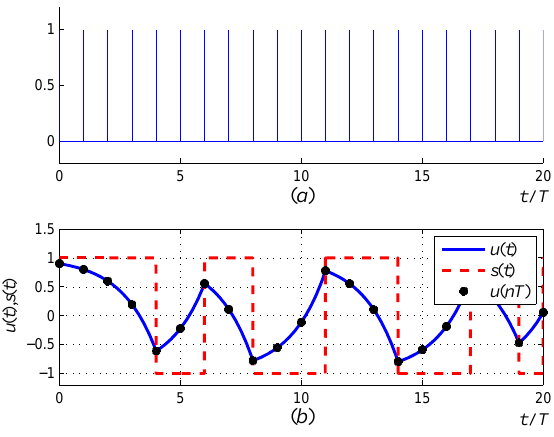
Figure 1. The waveform states of the hybrid system. ( a ) The periodic switching pulse; ( b ) The continuous state, discrete state, and state at the switching point of the hybrid